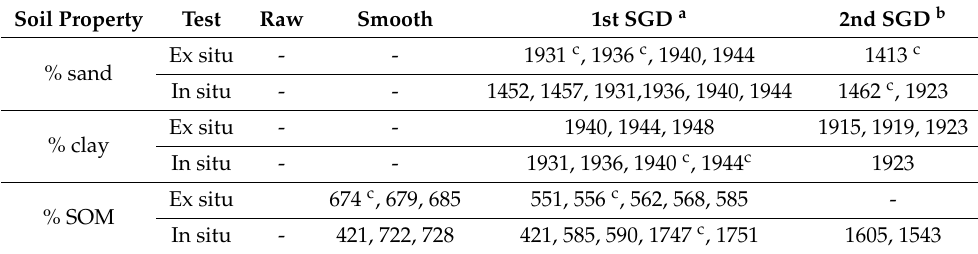
Table 4. vis–NIR wavelengths (nm) indicating the lowest critical error’s when predicting % sand, % clay and SOM content.